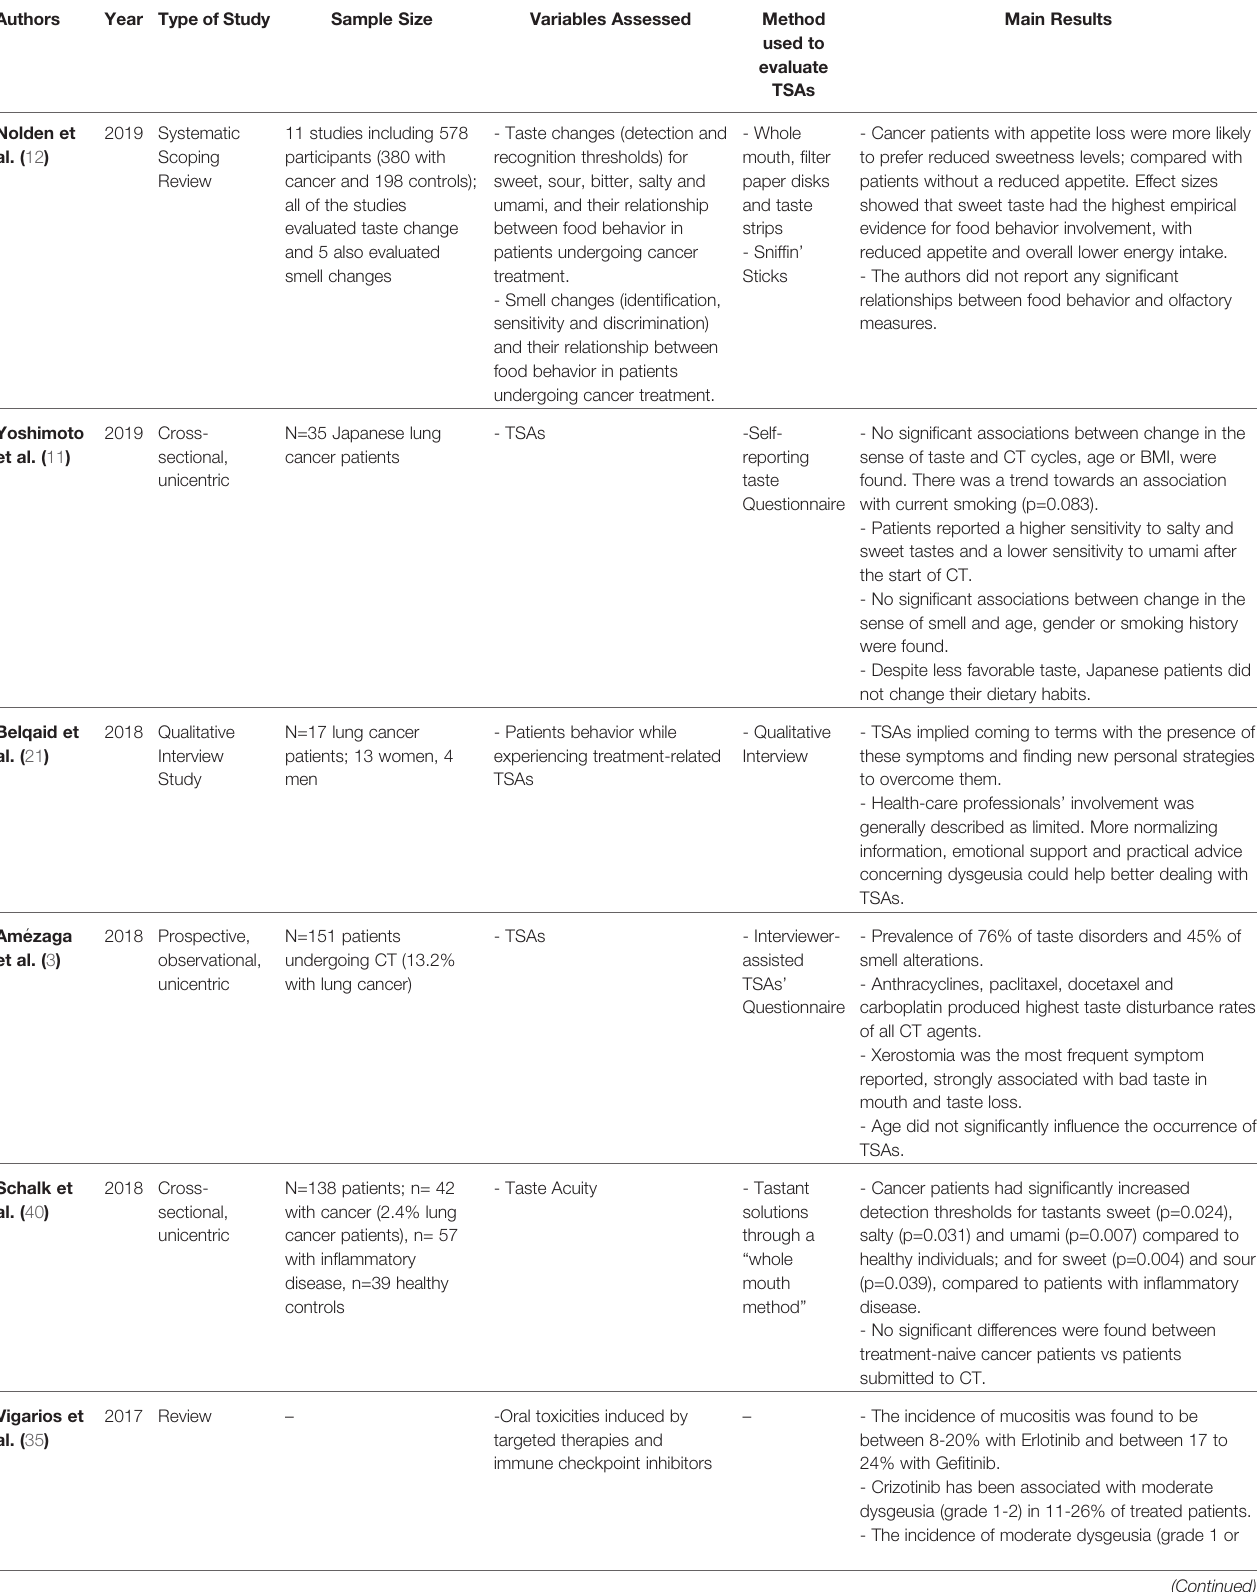
TABLE 3 | Summary of evidence concerning lung cancer patients undergoing systemic treatment included in the